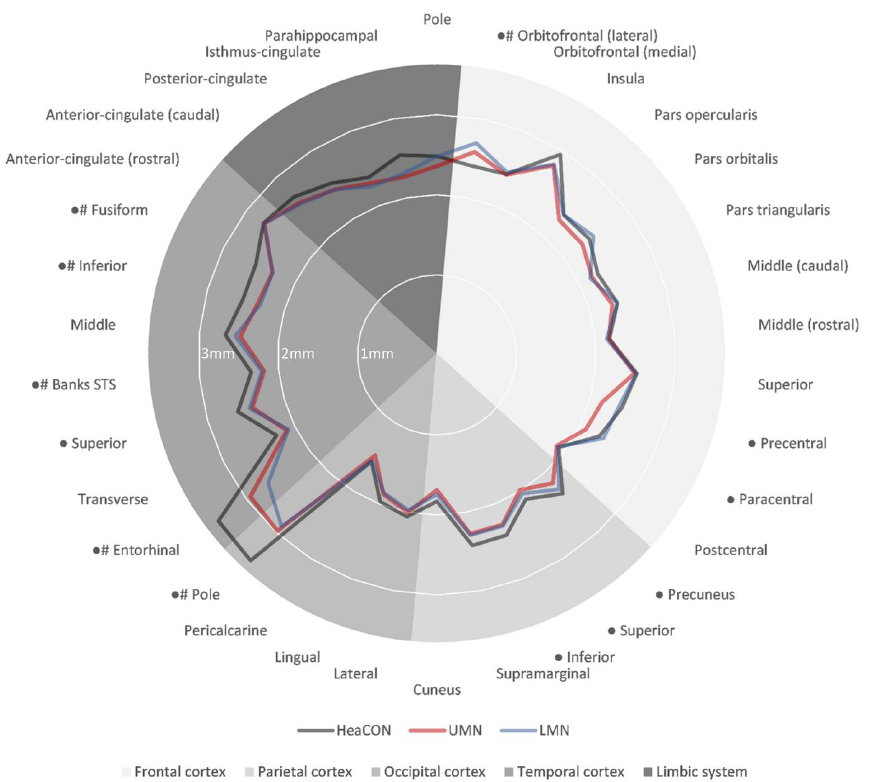
Figure 1. Cortical thickness of 34 brain regions from the left hemisphere for healthy controls (HeaCON indicated by the grey line), upper motor neuron (UMN indicated by the red line) and lower motor neuron patients (LMN indicated by the blue line). The grey shades depict different lobes, i.e., the frontal lobe, parietal lobe, occipital lobe, temporal lobe and limbic lobe. Significant differences between UMN patients and HeaCON are marked with a “●”, and those between LMN pa- tients and HeaCON are marked with a “#”. HeaCON, healthy controls; LMN, lower motor neuron patients; UMN, upper motor neuron patients. Compared to the HeaCON, the ALS group (including UMN and LMN patients) showed reduced CT in the temporal pole, entorhinal cortex, superior temporal sulcus, in- ferior temporal gyrus and fusiform gyrus. Increased CT was observed within the lateral orbitofrontal cortex in patients with UMN and LMN (Figure 2).